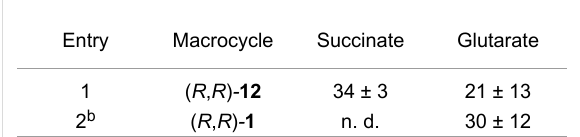
Table 2: Binding constants (M − 1 ) for the 1:1 complexes between ( R , R ) - 12 or ( R , R ) - 1 and dicarboxylate anions in CDCl 3 .